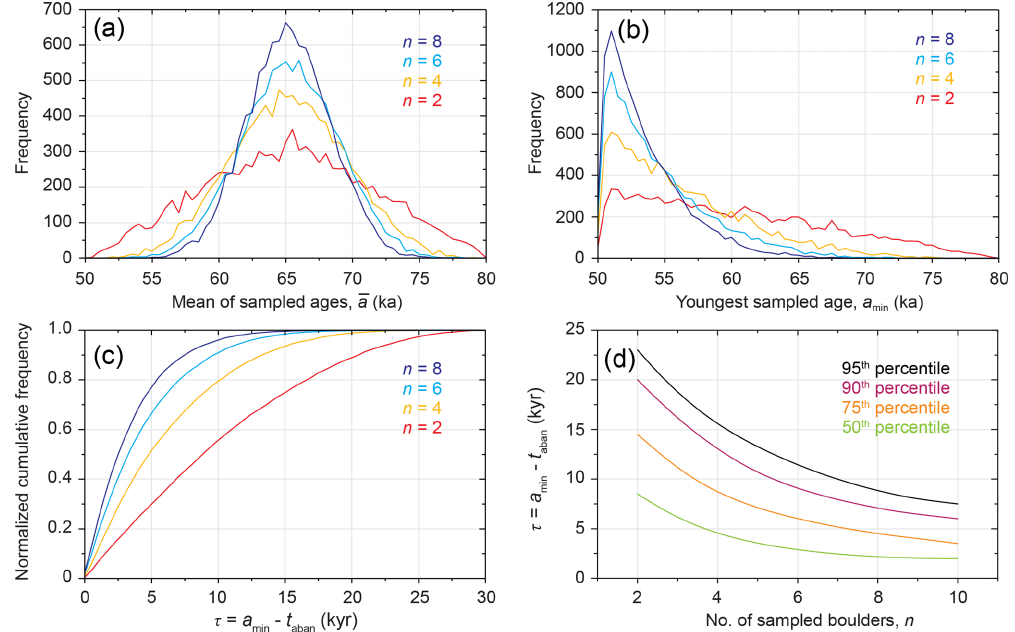
Figure 3. Example results of the artificial-data experiments for a surface active from 80 to 50ka ( T = 30kyr). A number of ages, n , were randomly sampled from the surface 10000 times. (a) Frequency distributions of resulting mean sampled age, a . (b) Frequency distributions of the youngest sampled age, a min . (c) Cumulative frequency distributions of τ normalized to a sum of 1. (d) Selected percentiles of τ plotted against n